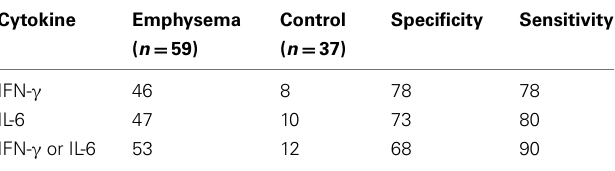
Table 2 | Sensitivity and specificity of γ -6 spot (ELISpot) assay.